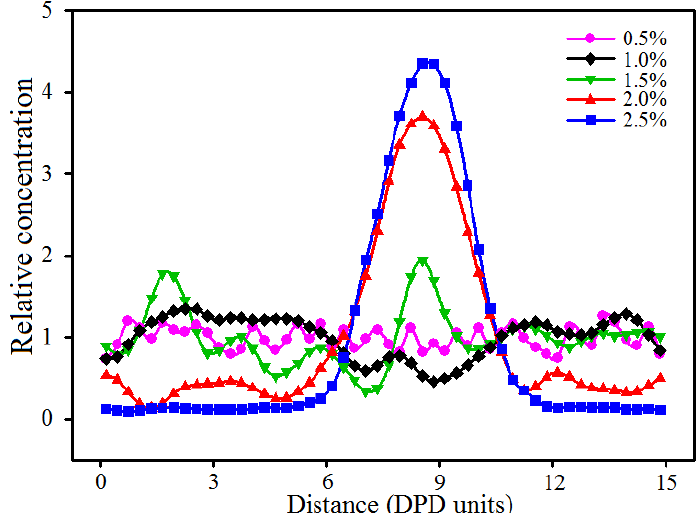
Figure 7. Relative concentration distribution functions of nano-silica in 10% PVA/10% PAM blended hydrogels with different nano-silica contents.